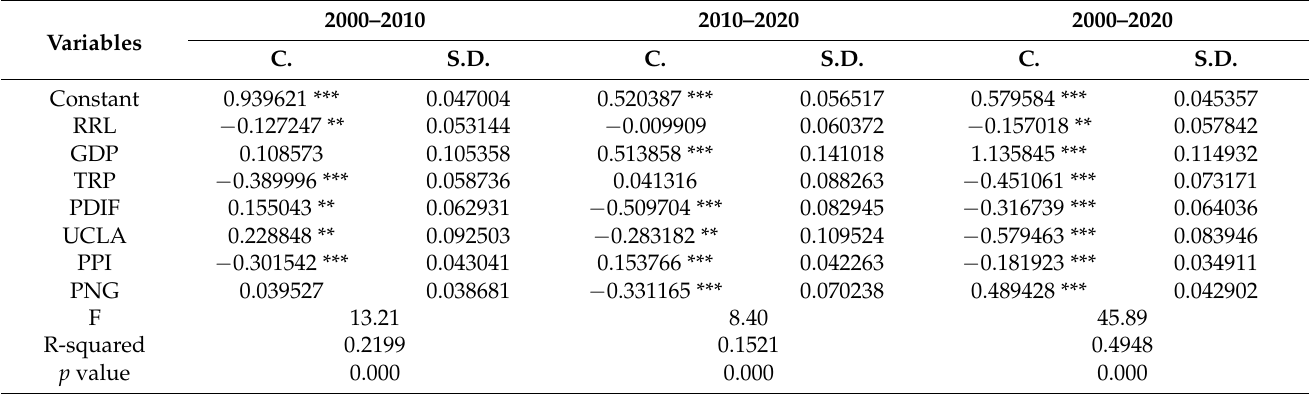
Table 5. Analysis of the direct impact of RRL change on